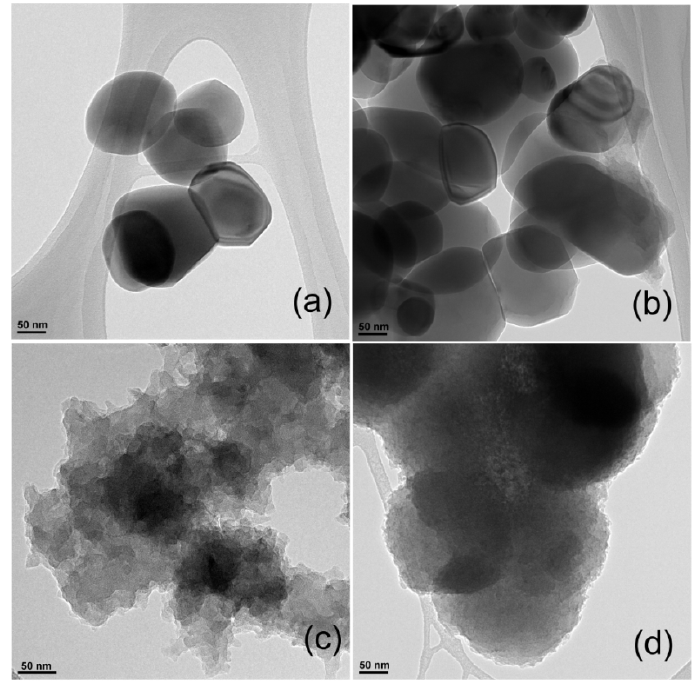
Figure 5. TEM images of: ( a ) TiO 2 , ( b ) TiO 2 –CuO, ( c ) PANI, and ( d ) PANI@TiO 2 –CuO.